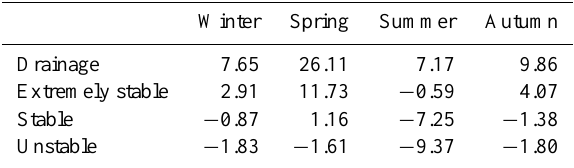
Fig. 9. Medians of BV and wind speed for stable situations during the night. Average interquartile range was 0.016s − 1 for BV and 4.6ms − 1 Figure 9.- Medians of BV and wind speed for stable situations during the night. Average for wind speed. interquartile range was 0.016 s -1 for BV and 4.6 m s -1 for wind speed. Table 2. Seasonal medians of CO 2 concentrations (ppm) during the night for different stability conditions in the lower atmospheric boundary layer. Trend and mean value were